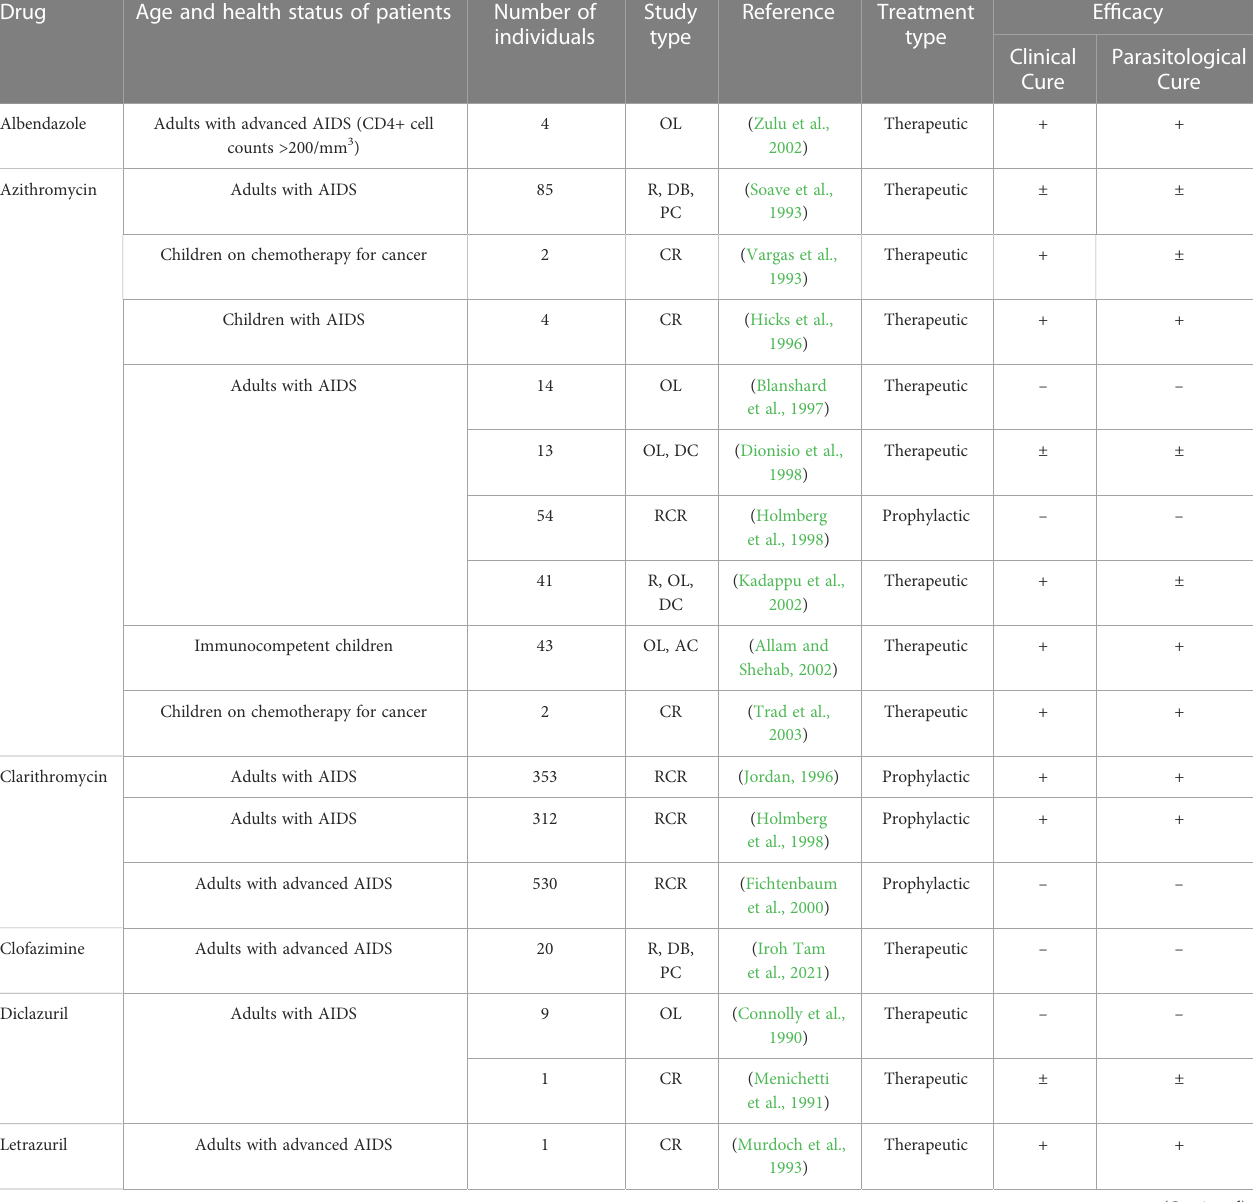
TABLE 1 Ef fi cacies of treatments tested against cryptosporidiosis in human patients. Drug Age and health status of